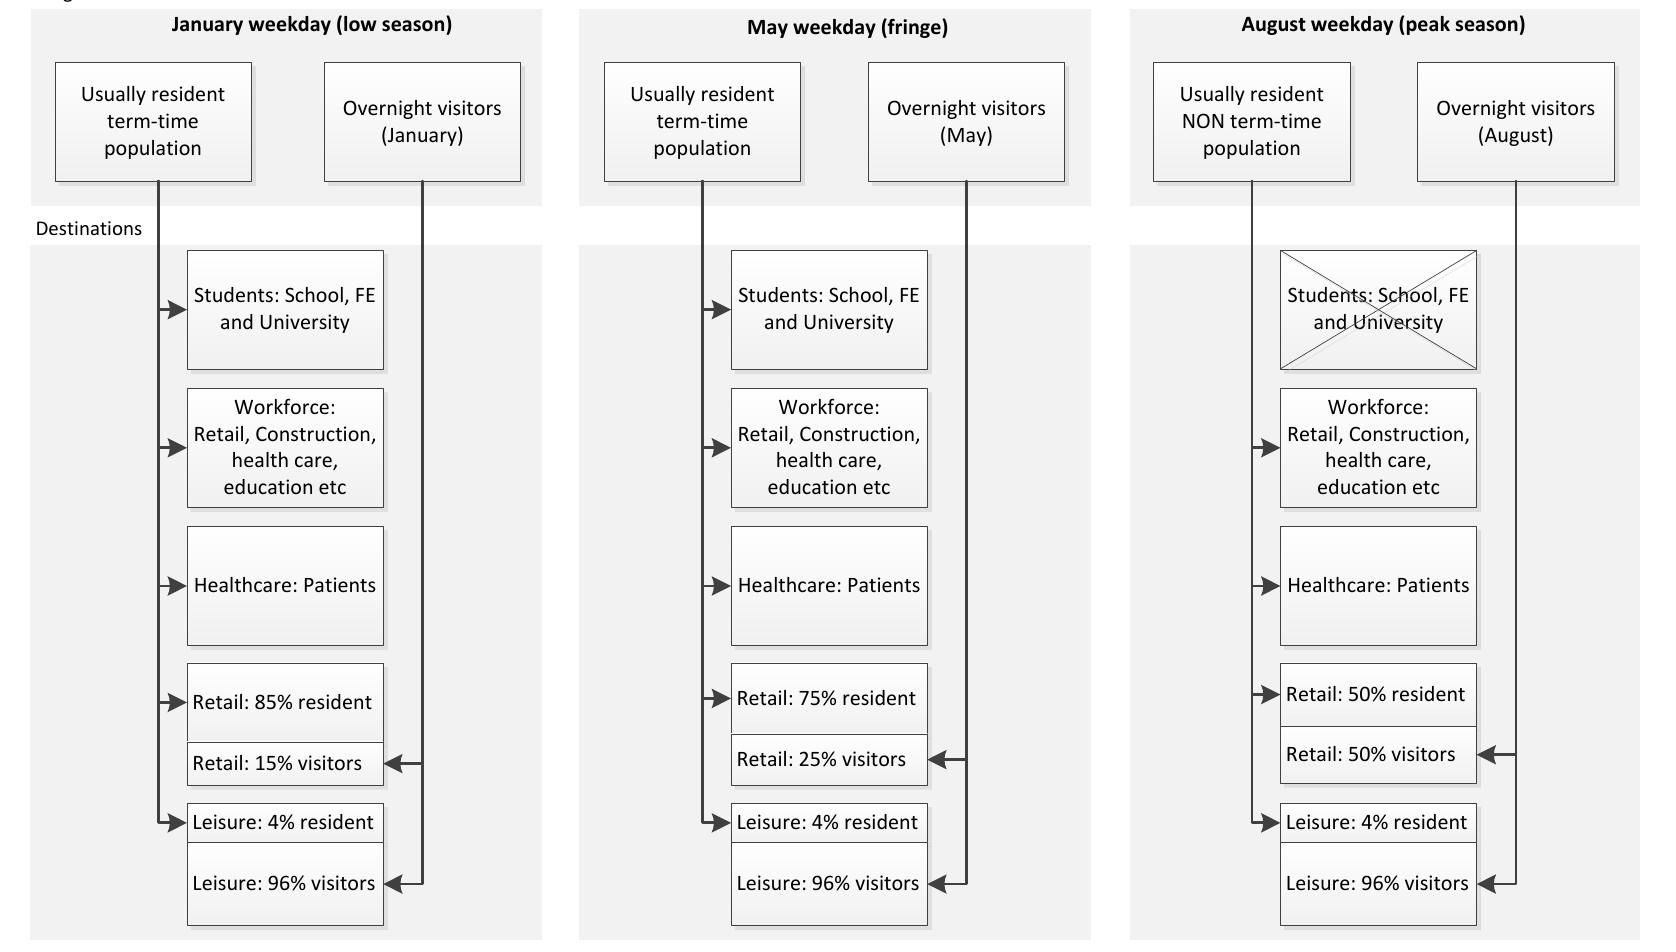
Figure 2. Diagrammatic overview of population origin and destination datasets used to construct the St Austell case